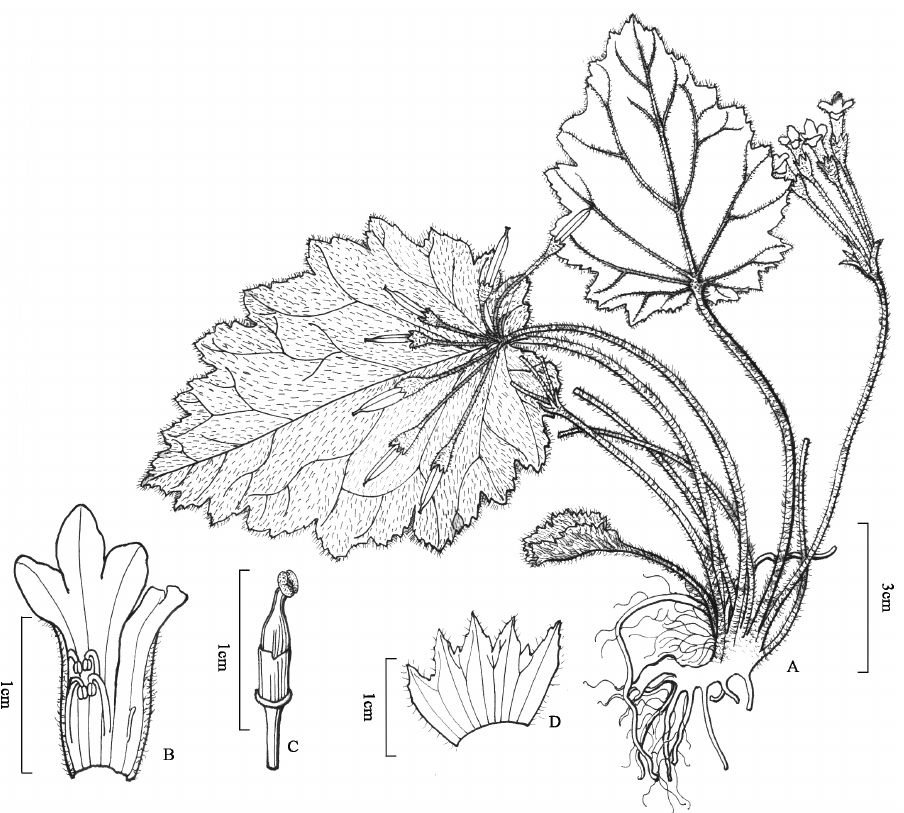
Figure 7. Oreocharis wenshanensis W.H.Chen & Y.M.Shui, sp. nov. A plant B opened corolla showing sta- mens and staminode C pistil showing ovary, disc and stigma D calyx. (Drawn by Ling Wang from